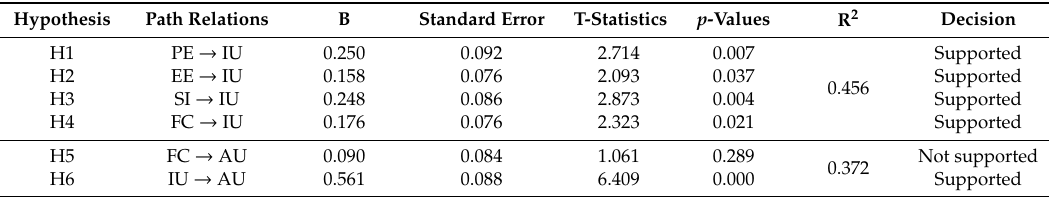
Table 3. Testing hypotheses with direct e ff ects.